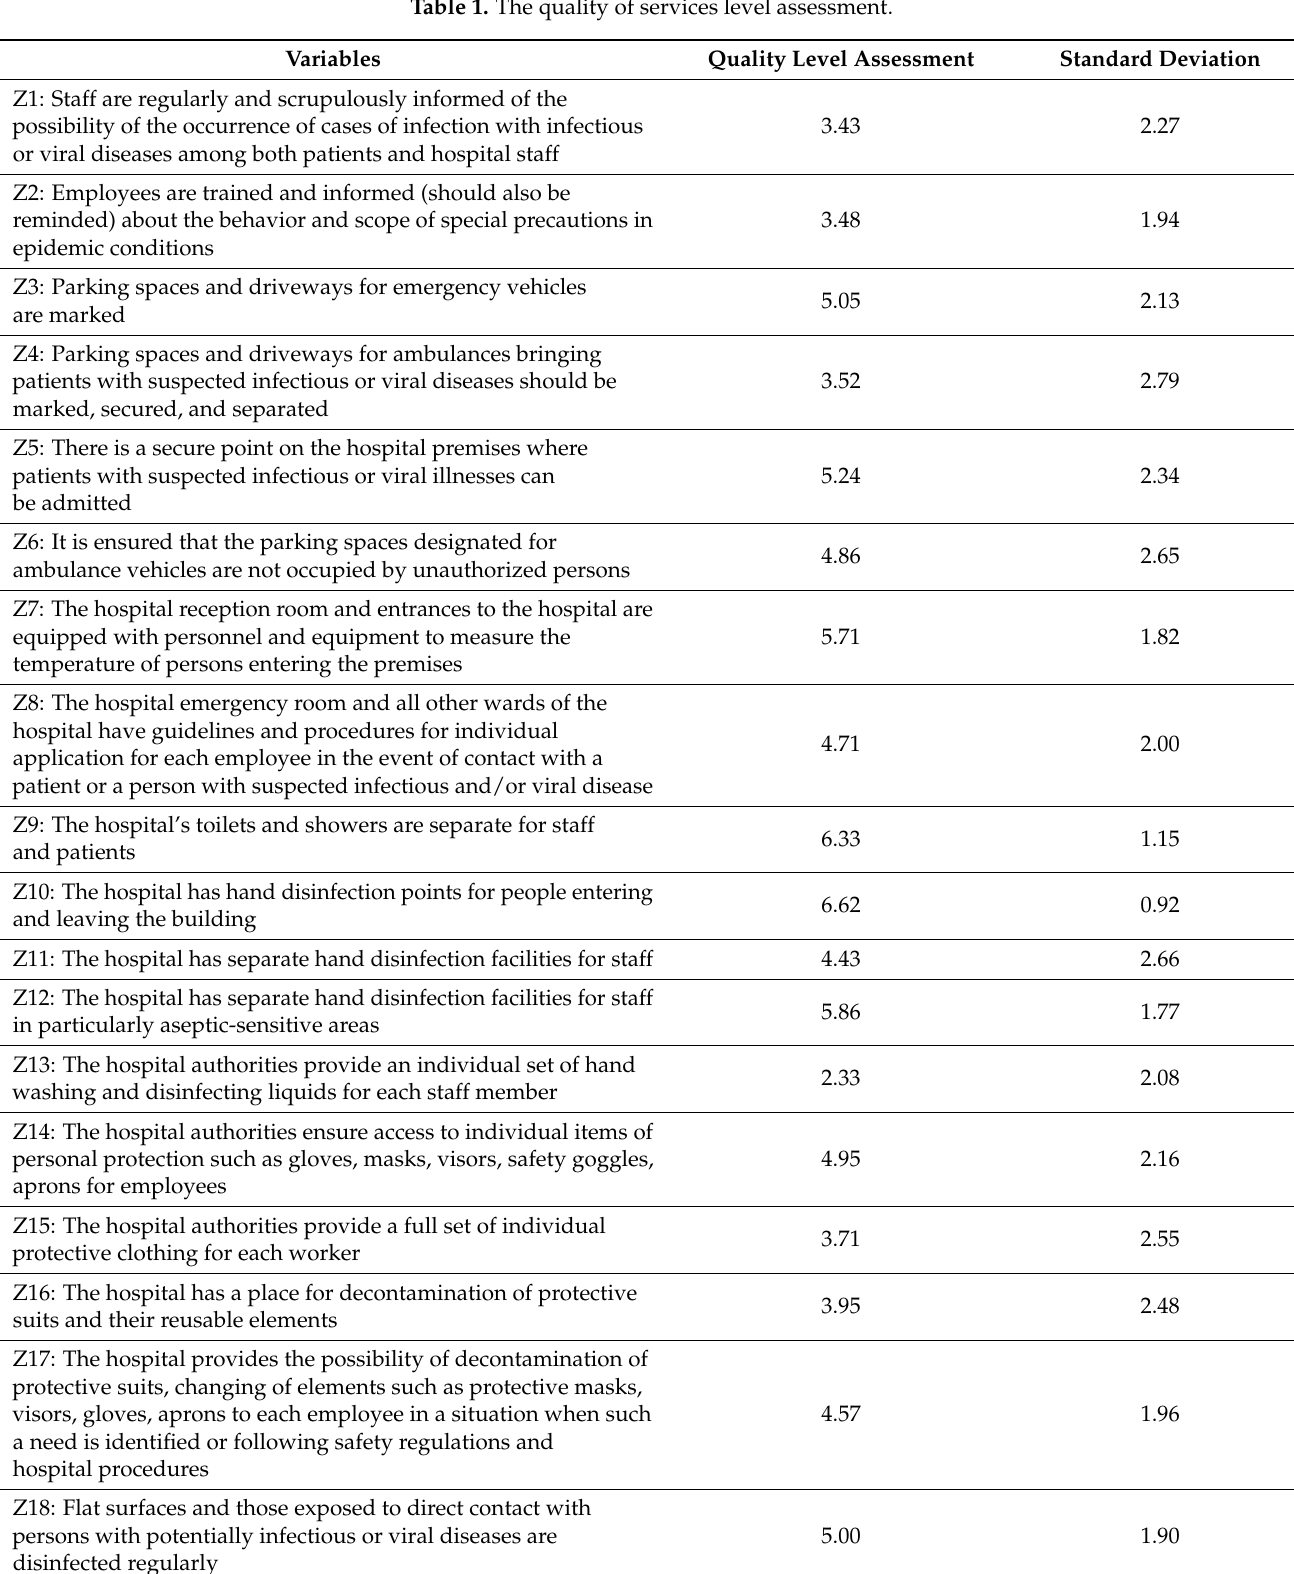
Table 1. The quality of services level